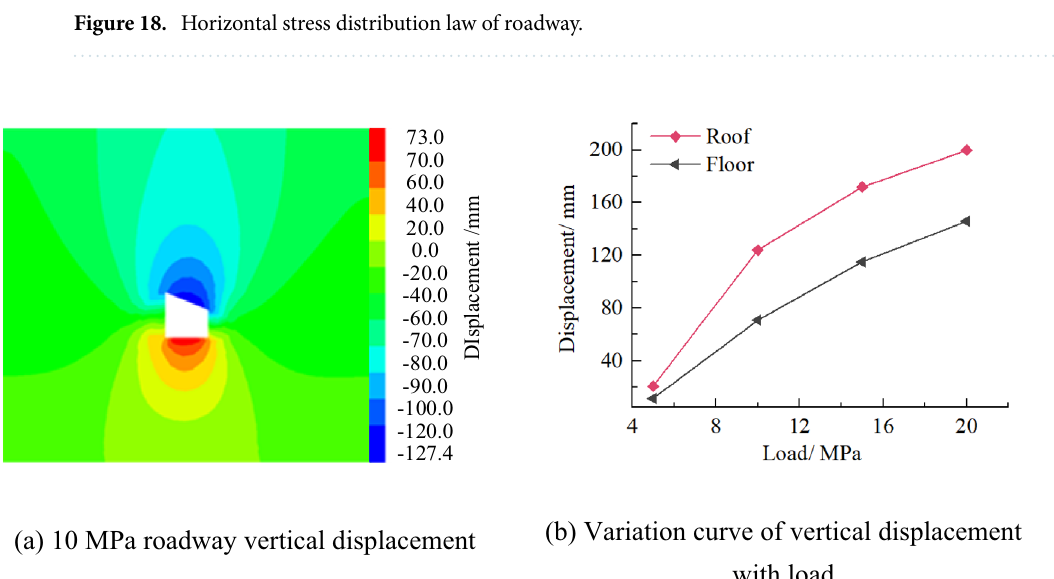
Figure 19. Distribution law of roadway vertical